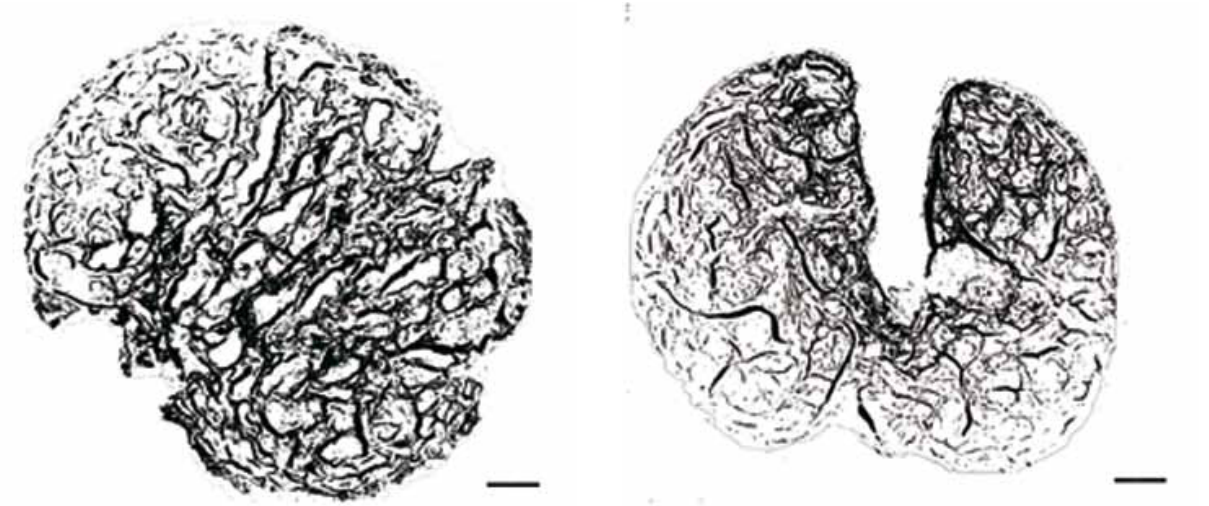
Figure 8 - Area of the corpus cavernosum sinuses of rabbits from the diabetic group. Binarized image taken at 40x mag- nification. Scale bar: